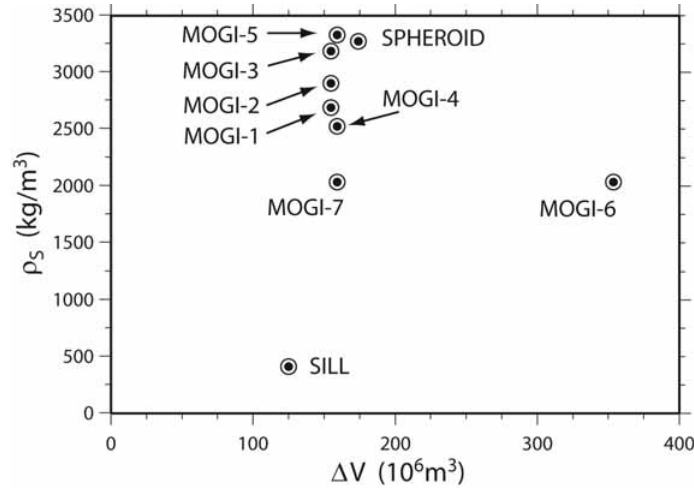
Fig. 11. Density calculations versus volume variations of the proposed